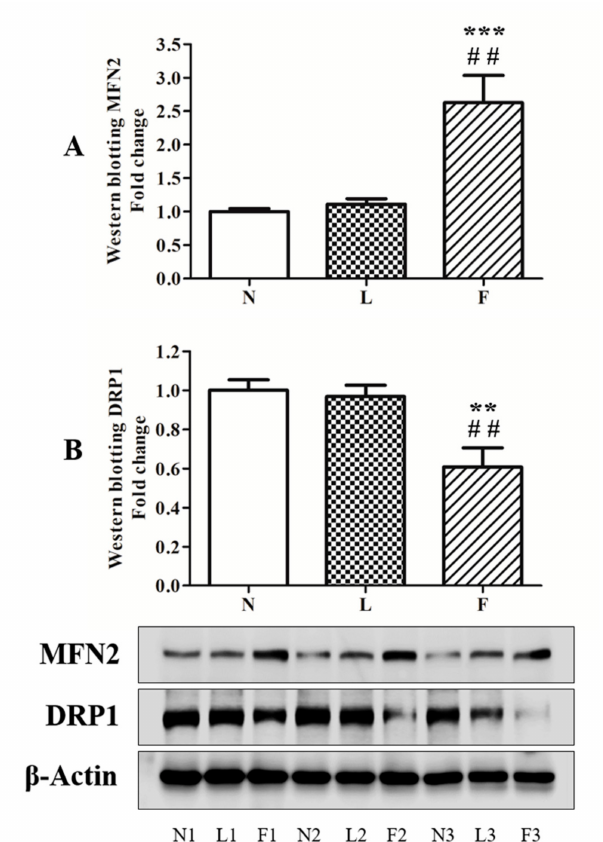
Figure 7. MFN2 ( A ) and DRP1 ( B ) levels. Dynamic proteins contents were monitored by western blotting. The figure shows a representative western blot and the densitometric analyses were graphically represented as mean ± SEM of six di ff erent animals for each group expressed as fold change vs. N. Significant di ff erences are shown: ** p < 0.01 vs. N; ## p < 0.01 vs